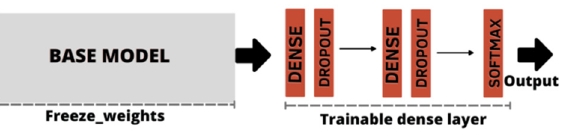
Figure 8. Freeze weights base model, followed by dense layer construction with dropout application.